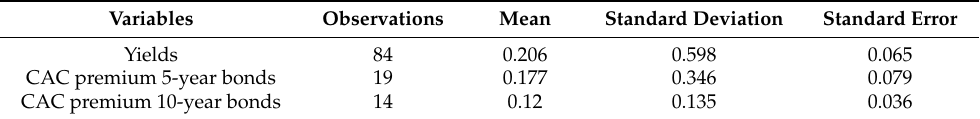
Table 2. Summary of descriptive statistics CACs (Source: Authors).